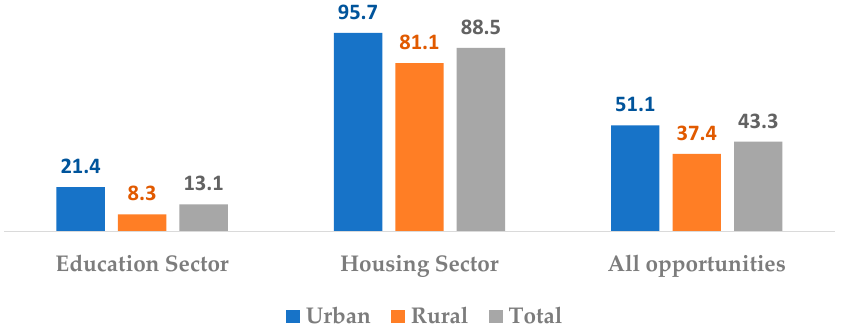
Figure 7. HOI for aggregate opportunities among youth 18–29 years by Residence. Note: Authors, data from HCP open data (www.hcp.ma) (accessed on 1 April 2022).